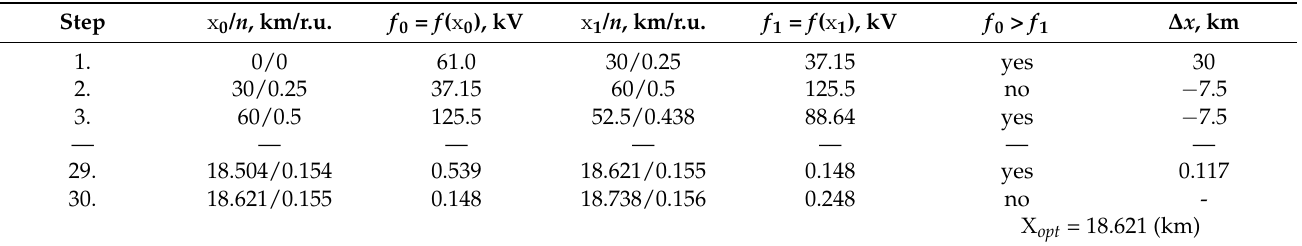
Table 2. An example of the implementation of the FL on OHPLs in the case of refusal from the two-stage